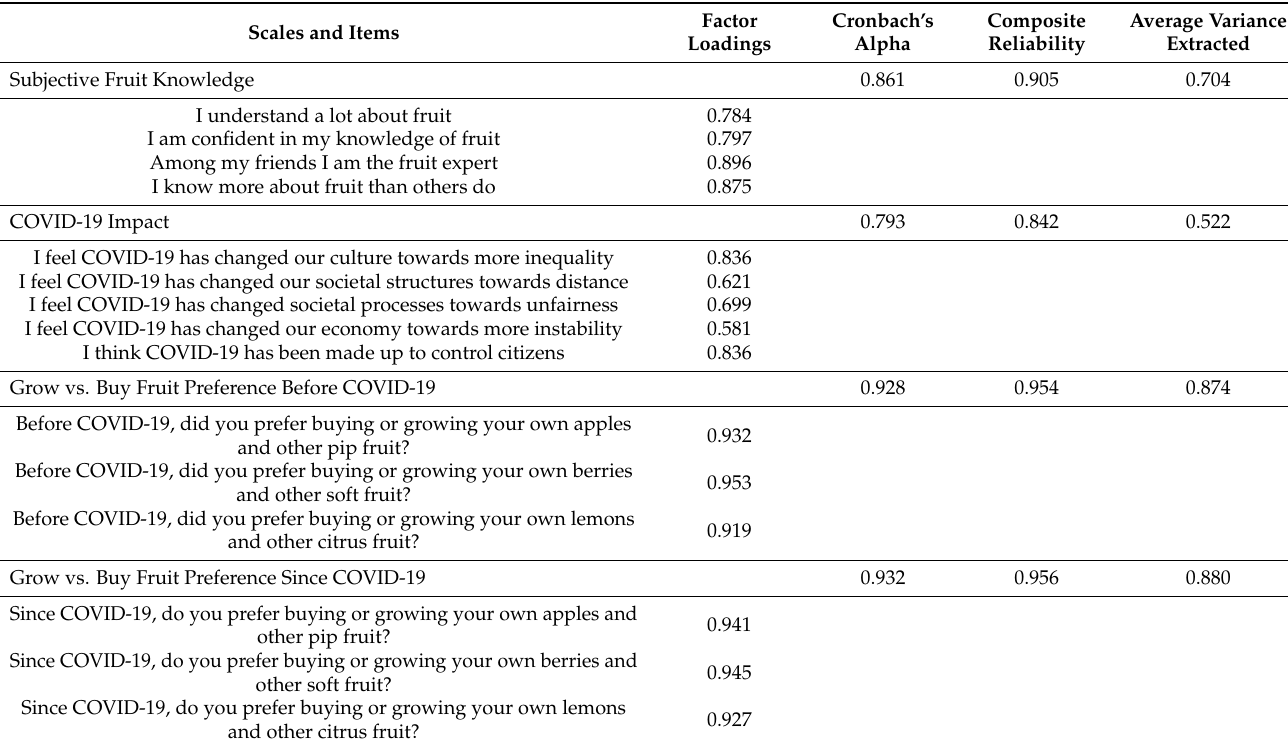
Table 2. Reliability and Validity Check.